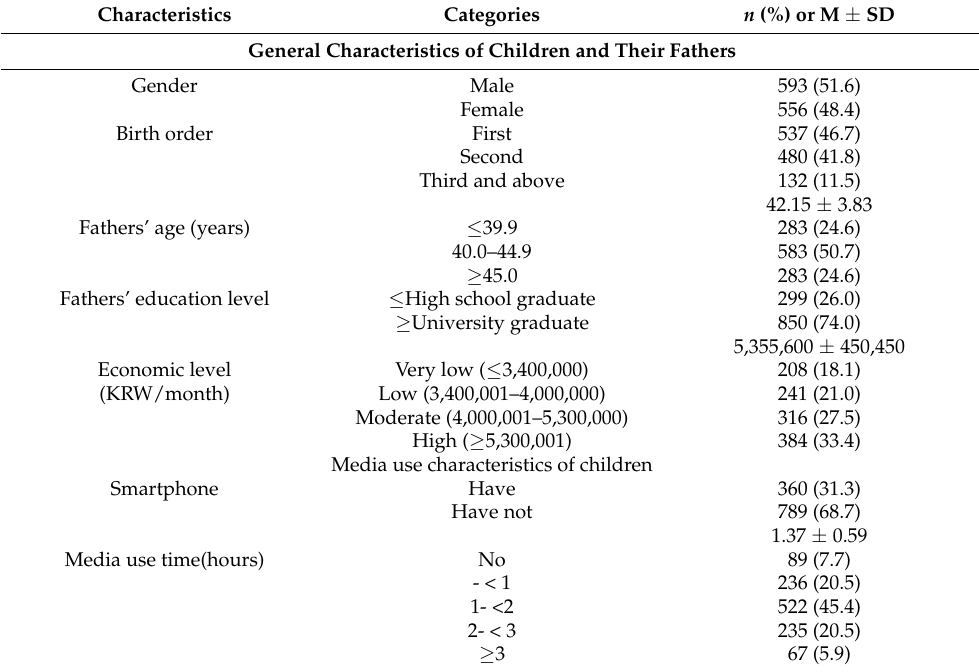
Table 1. Participants’ characteristics (N =